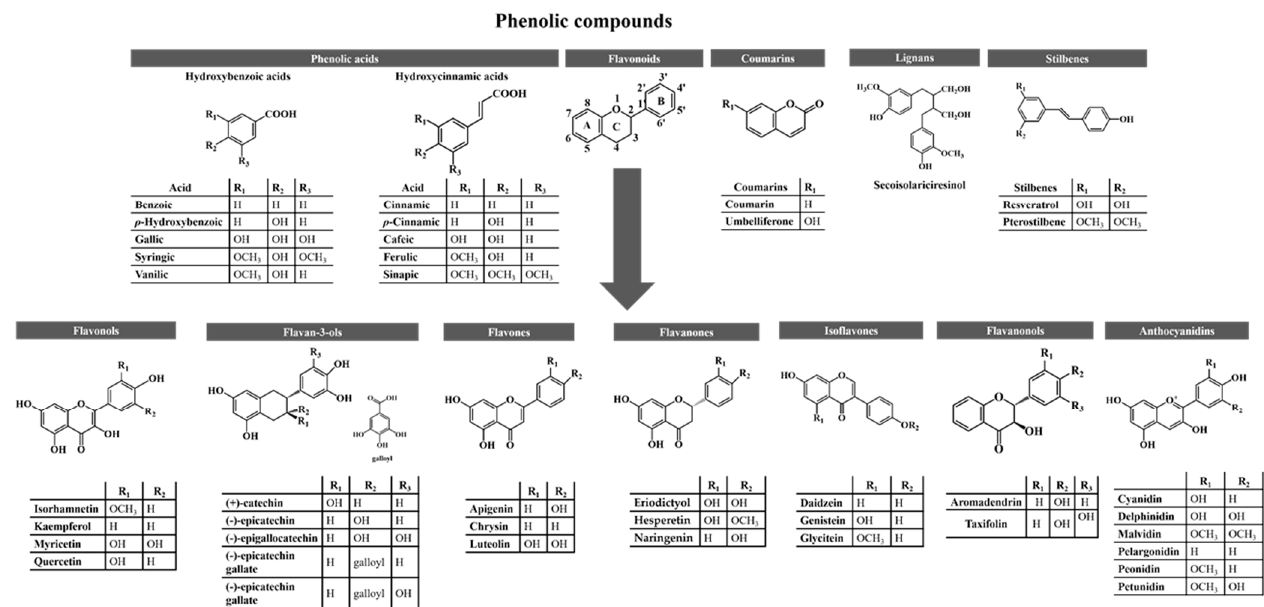
Figure 1. Main phenolic compounds. Non-flavonoids comprise coumarins, phenolic acids, lignans and stilbenes, while flavonoids include flavonols, flavan-3-ols, flavones, isoflavones, flavanonols and anthocyanidins. Among them, flavonoids are the most found in nature.